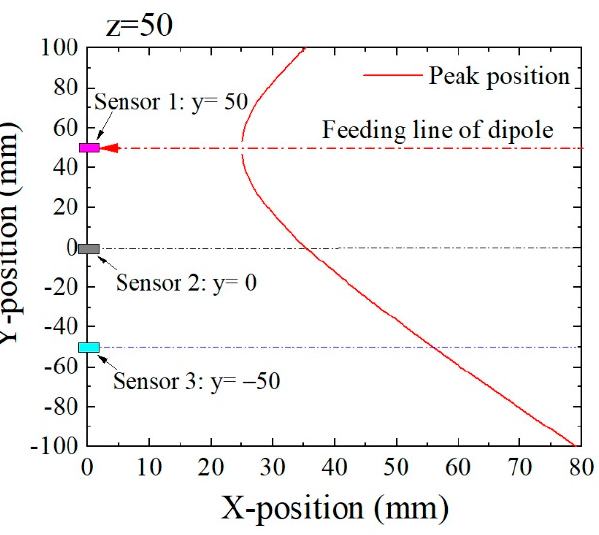
Figure 7. Variation of the extreme point’s position when a magnetic dipole was fed on y = 50, z = 50. Figure 8 is the analogous estimation of the extreme point when the feeding line